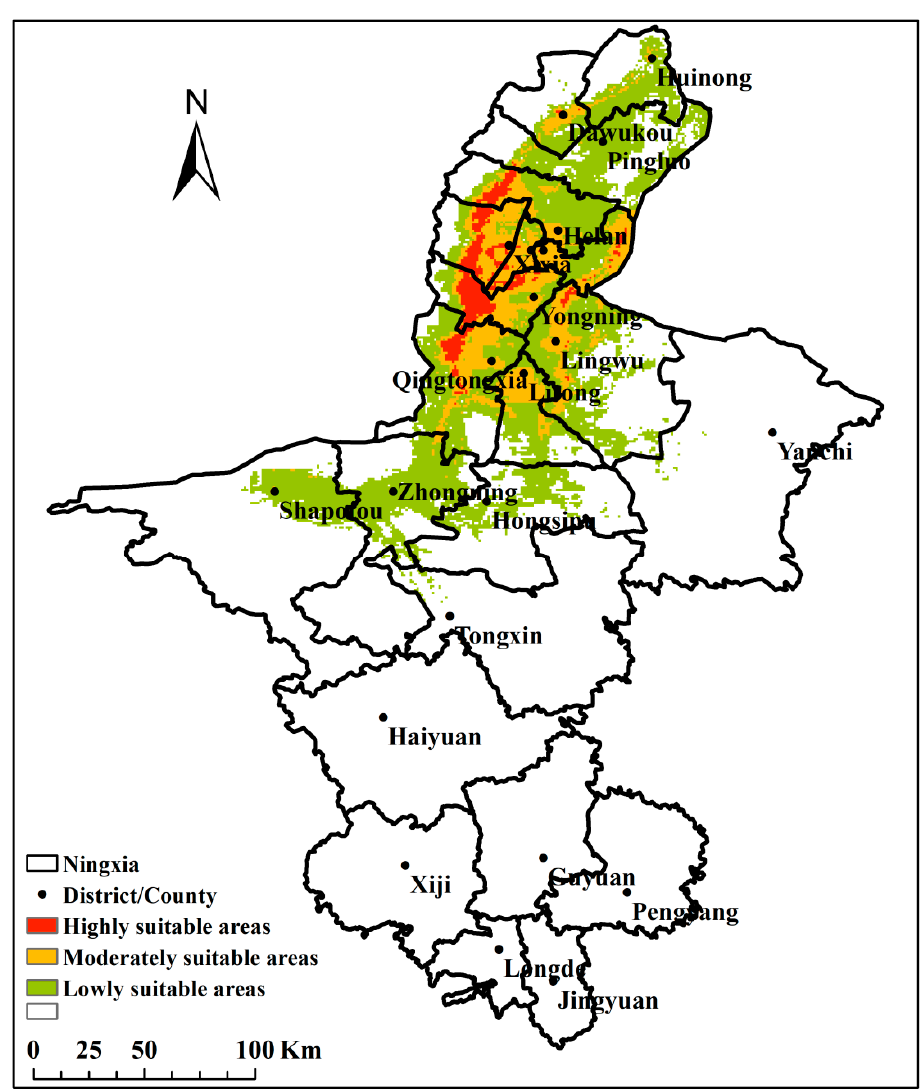
Figure 6. The potential suitable areas for wine grape under current climate in Ningxia.